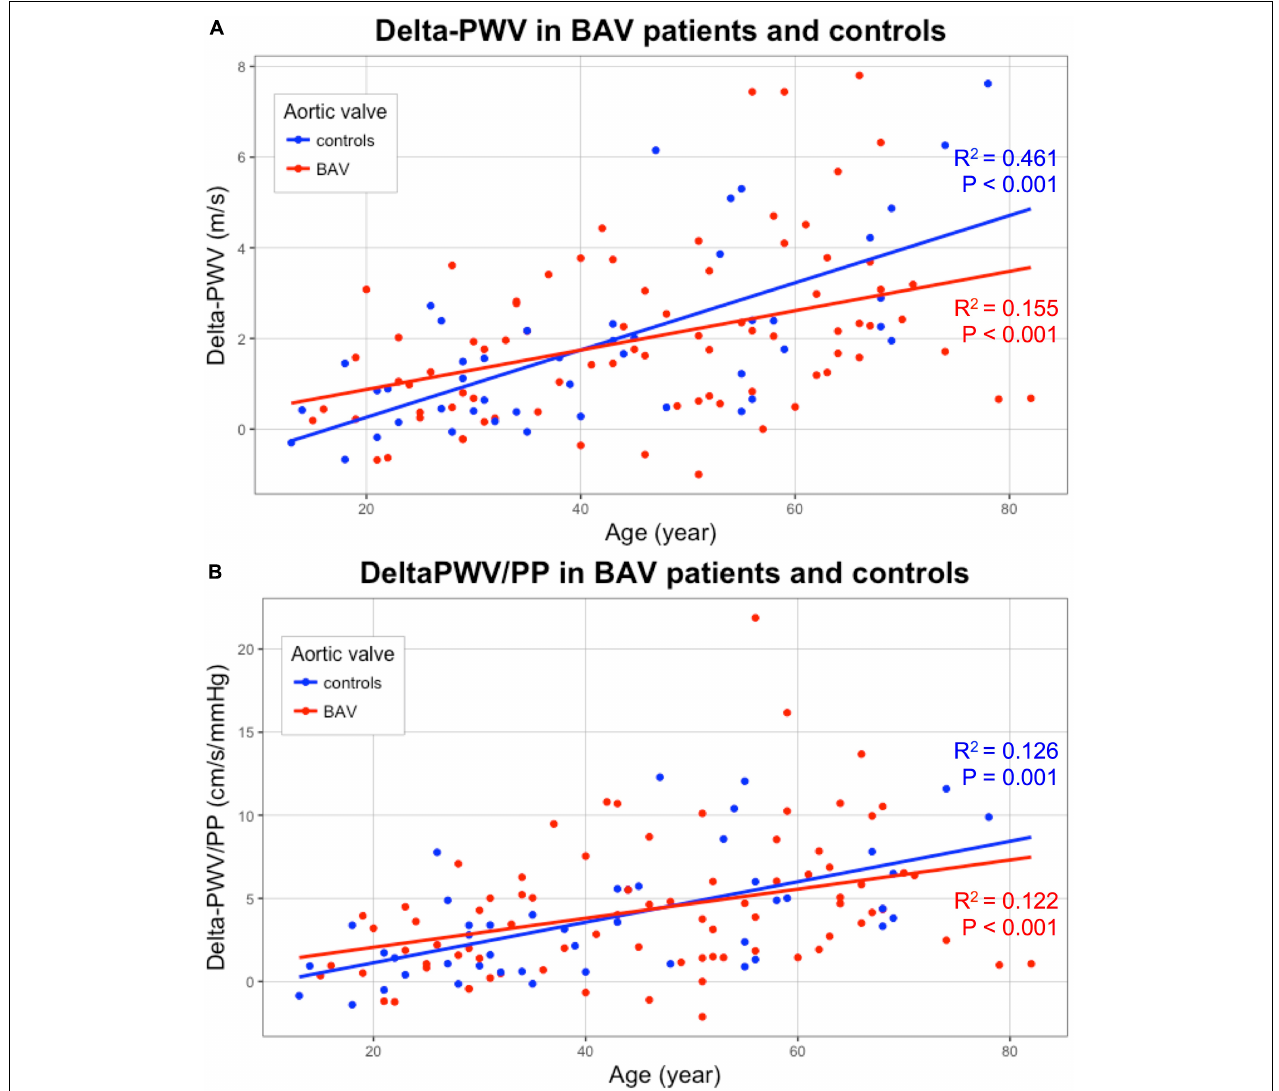
FIGURE 4 | Correlation of carotid stiffening indicators ( Y -axis) with age ( X -axis): Delta-PWV (A) and Delta-PWV/PP (B) , for patients with bicuspid aortic valve (BAV) (red) and controls (blue). BAV, bicuspid aortic valve; PWV, pulse wave velocity; PP, pulse